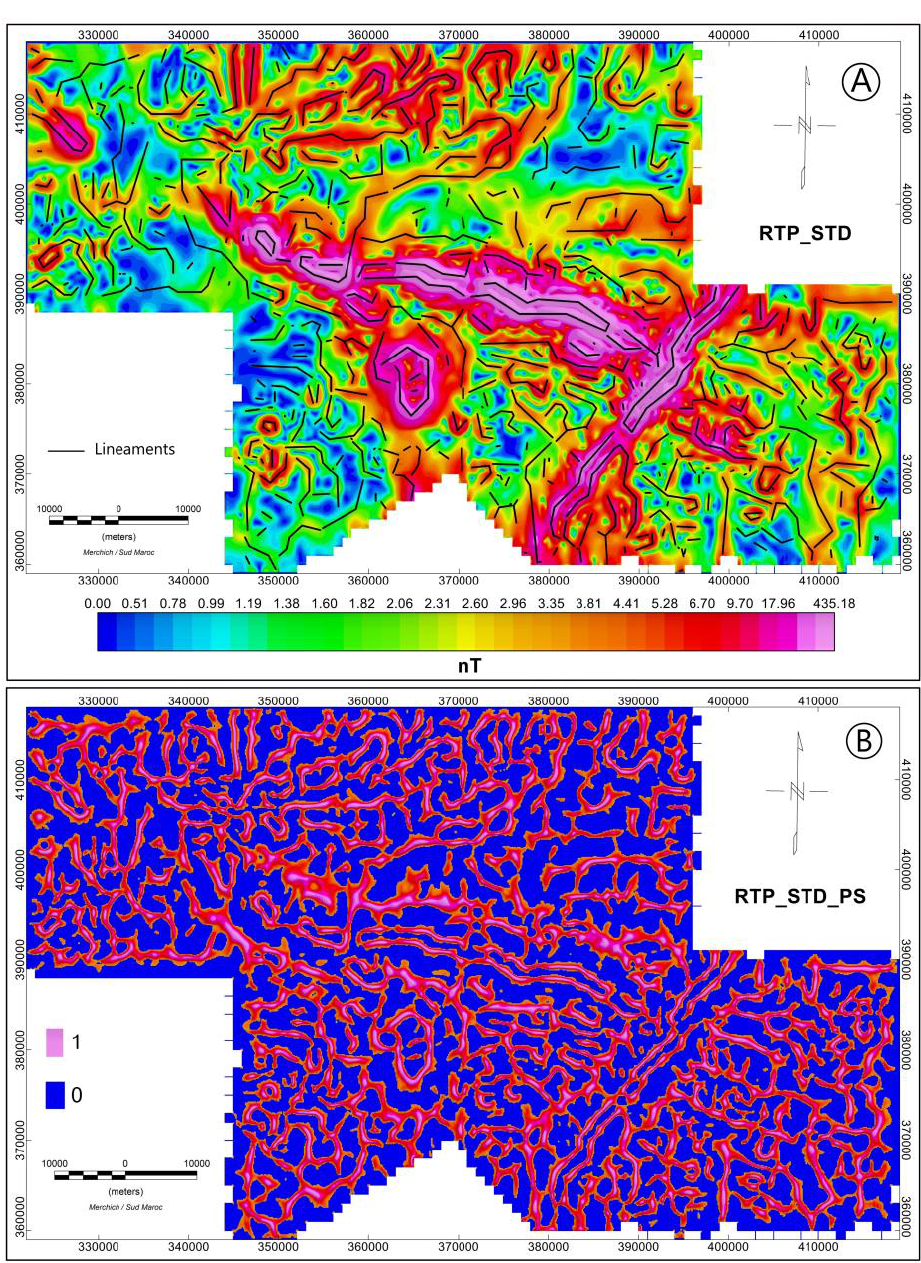
Figure 13. ( A ) Standard deviation of the RTP with the final obtained contacts and faults. ( B ) Thresholded amplitude of RTP_STD.